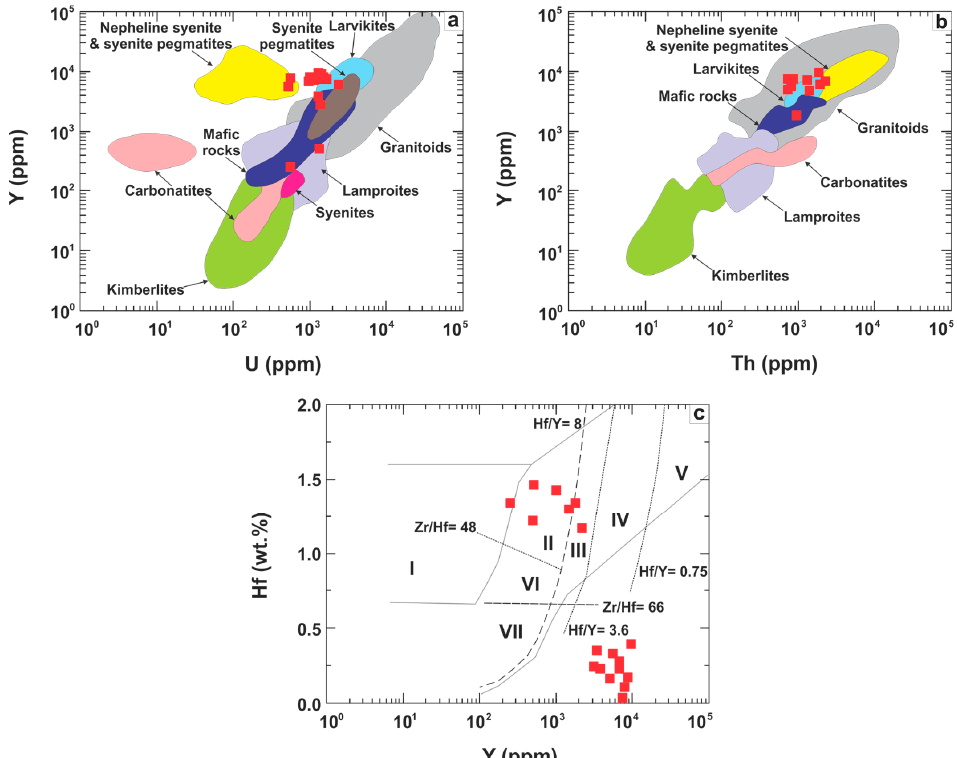
Figure 16. Trace element correlations for zircons. ( a ) Y (ppm) vs. U (ppm); ( b ) Y (ppm) vs. Th (ppm); ( c ) Hf (wt %) vs. Y (ppm). Fields in ( a , b ) are from [77]; fields in ( c ) are from [78] (I = kimberlites, II = ultramafic, mafic and intermediate rocks, III = quartz-bearing intermediate and felsic rocks, IV = felsic rocks with ‘high’ SiO 2 content, V = greisens, VI =alkaline rocks and alkaline metasomatites of alkaline complexes, VII = carbonatites).